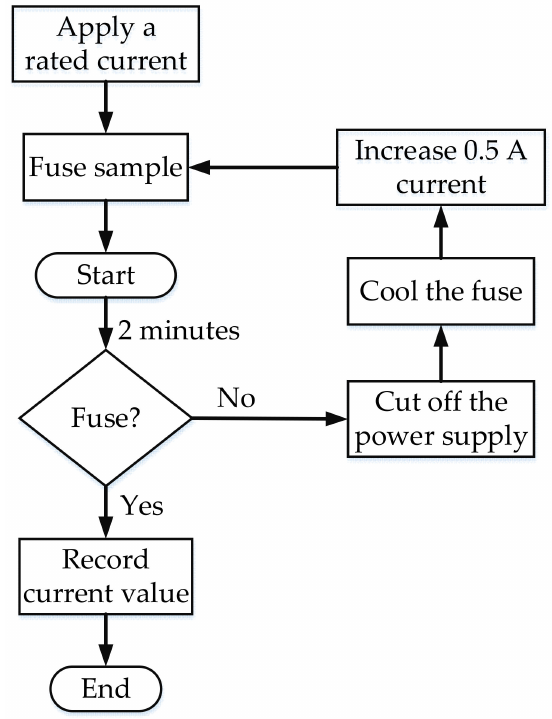
Figure 2. Flow chart for the